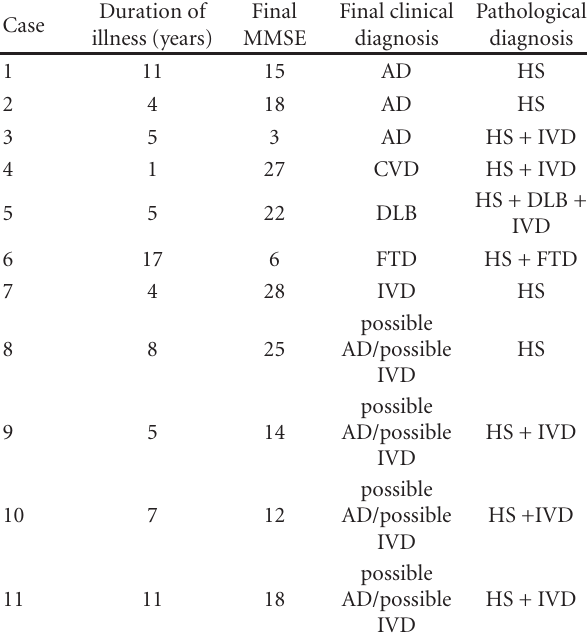
Table 3: Dementia severity, clinical diagnoses, and pathological diagnoses for AD